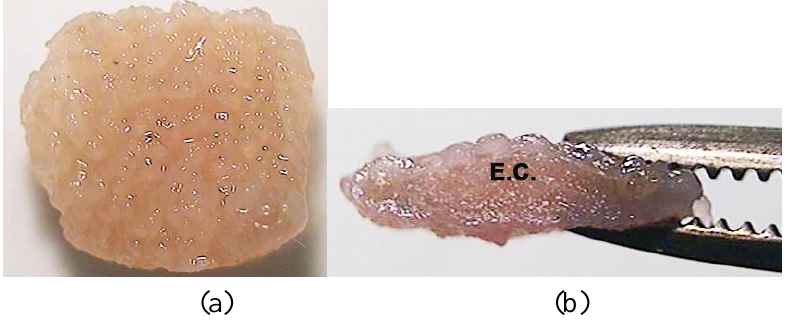
Figure 6. Macroscopic appearance of engineered cartilage in the cushion-type ( a , b ) and in the cylinder-type ( c , d ) scaffold at eight weeks after cultivation. The engineered cartilage can be easily handled with forceps due to its stable mechanical property. E.C., engineered cartilage in the scaffold